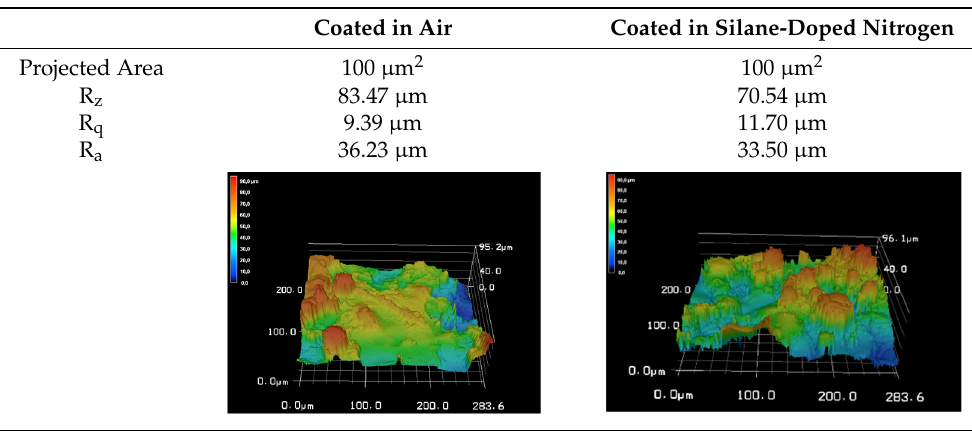
Table 2. Roughness values of the wire arc copper coating surfaces.